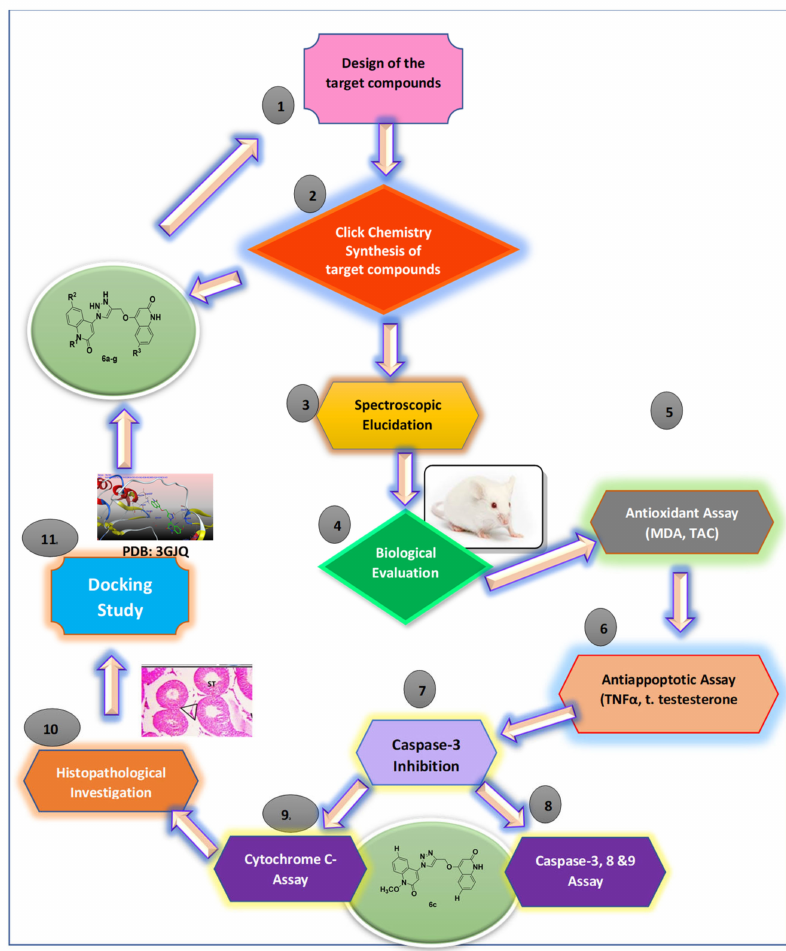
Figure 2. Schematic diagram illustrating all methodological